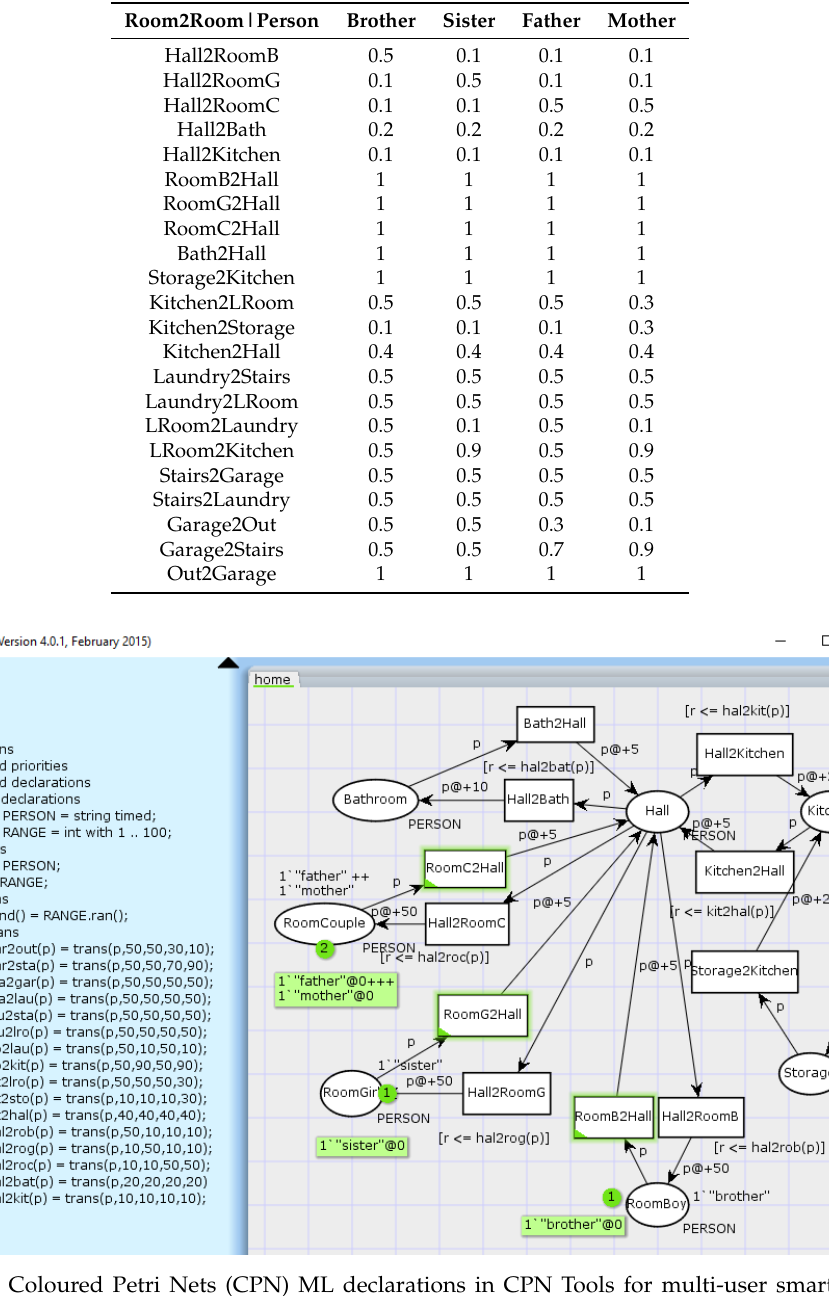
Table 1. Room transition probability for each of the four persons modeled.